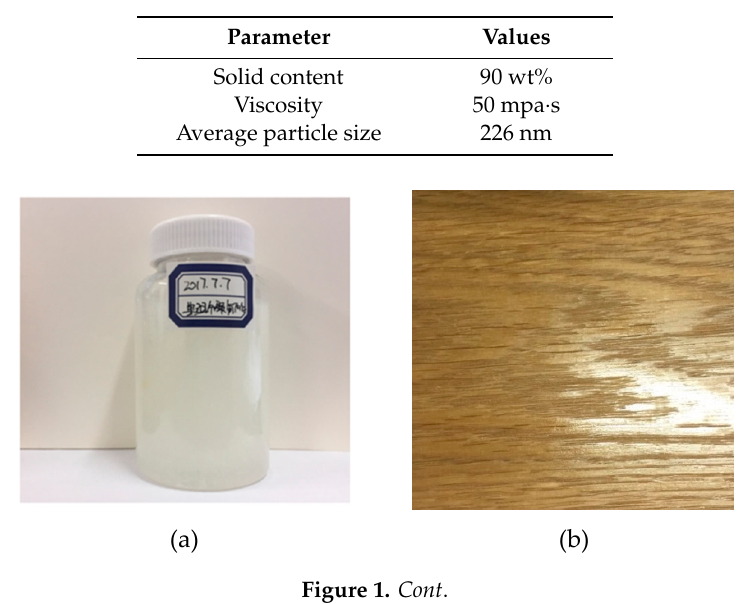
Table 2. Parameters of fast water-based UV curing PUA